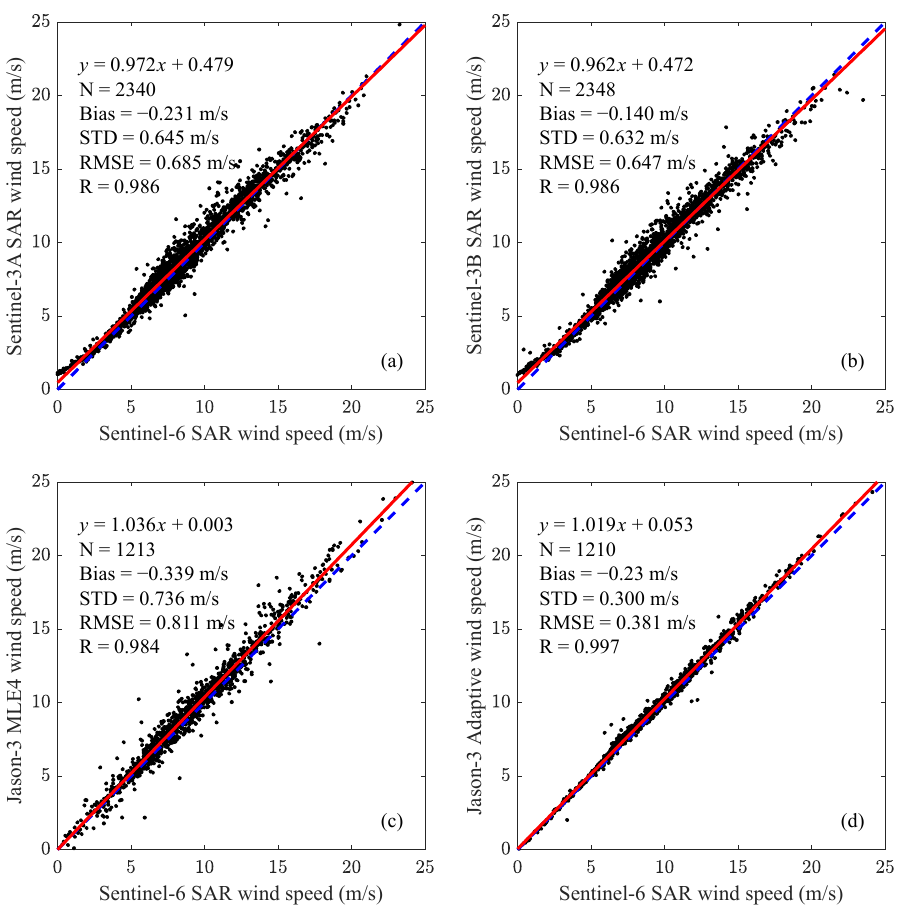
Figure 15. Scatterplots of Sentinel-6 wind speed measurements in SARM against ( a ) Sentinel-3A SARM, ( b ) Sentinel-3B SARM, ( c ) Jason-3 MLE-4 and ( d ) Jason-3 adaptive re-tracking measurements.